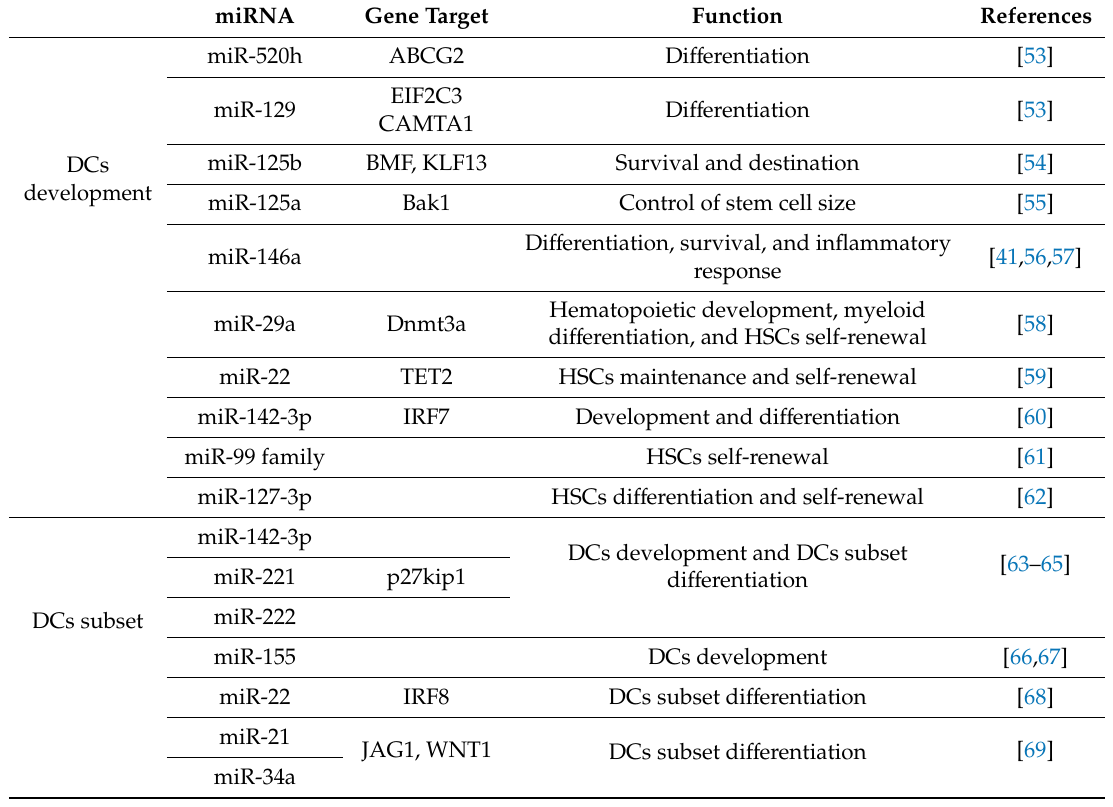
Table 1. miRNAs involved in DC development and di ff